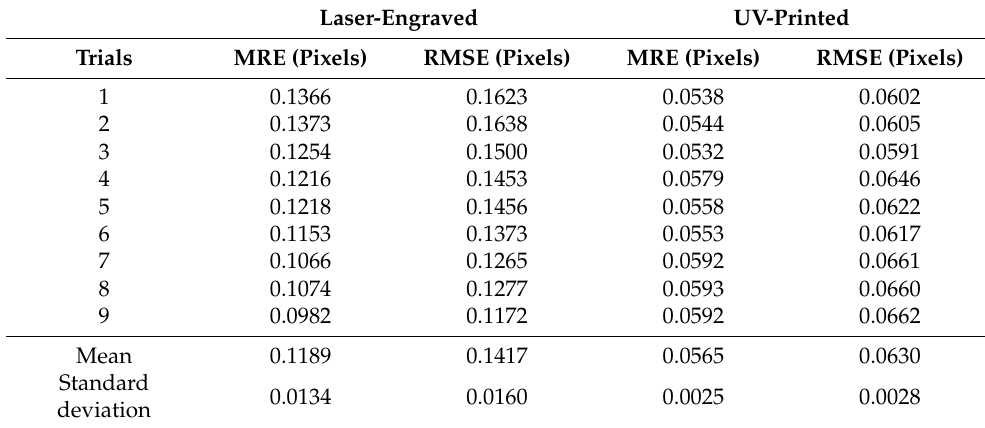
Figure 9. Distribution of the reprojection errors (RE) of all detected image points, using one calibration trial per selected checkerboards. ( a ) Laser-engraved checkerboard; ( b ) UV-printed checkerboard. Table 5. List of reprojection errors ( MRE and RMSE ) for the two calibration